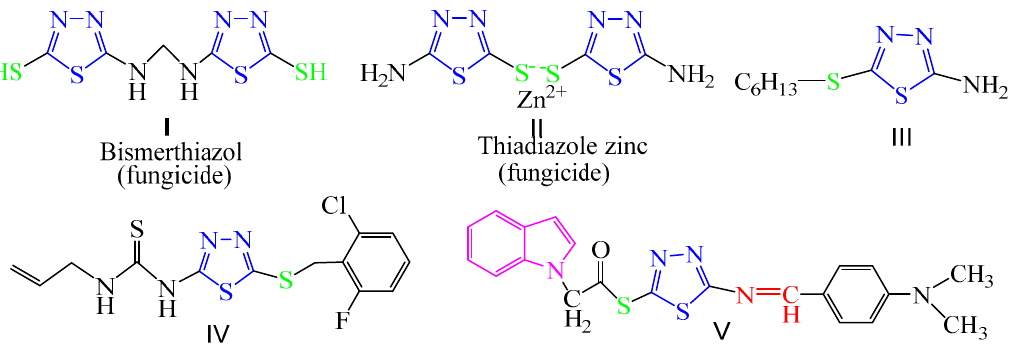
Figure 2. The structures of fungicides and antifungal activity compounds containing 1,3,4-thiadia-